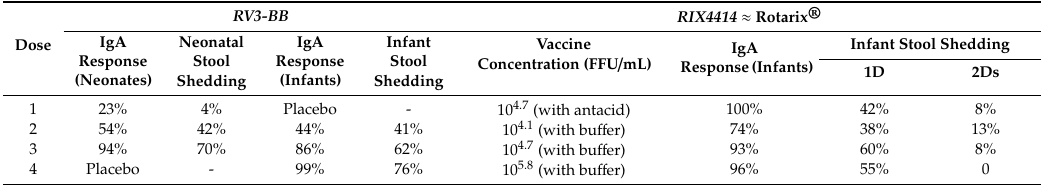
Table 3. Comparison between RV3-BB and RIX4414 neonatal oral live-attenuated human rotavirus (HRV)